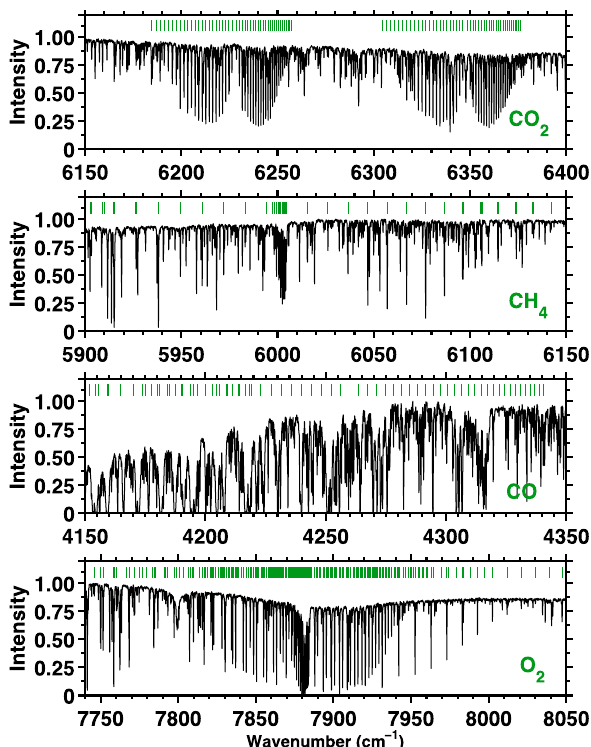
Fig. 3. Atmospheric absorption spectra measured using CLARS- FTS with a spectral resolution of 0.12cm − 1 on 3 September 2012. The measurement was taken by targeting at the land surface of Santa Anita Park (34.141 ◦ N, 118.042 ◦ W, 155m above sea level, 9.3km slant distance to the CLARS site), Arcadia, California. The green vertical bars indicate the spectral line positions of target gases of interests. The spectra were co-added using 12 single scan spectra centered at 10:33 local time (solar zenith angle 32.442 ◦ ) with total measurement time about 3min. The spectral signal-to-noise ratio (SNR) is 420 :